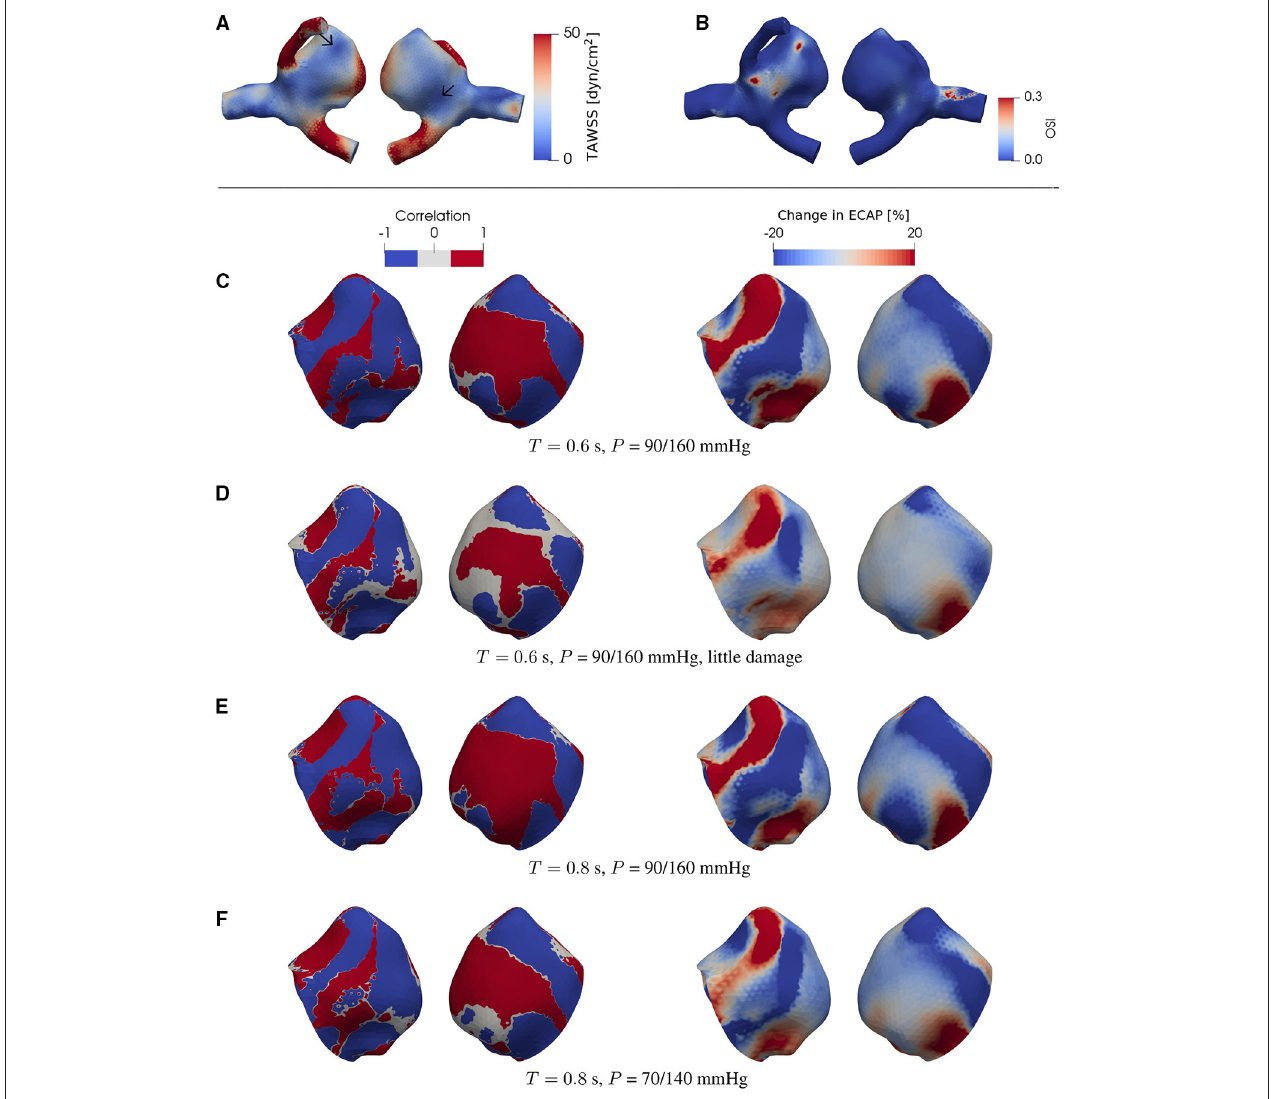
FIGURE 5 | The same type of data as in Figure 4 but now for a different patient-specific aneurysm [C0020 in Aneurisk dataset repository (Aneurisk-Team, 2012); see as Figure 1D ]. For each case investigated, the locations of low-WSS (indicated by arrows) remain intact during a full cardiac